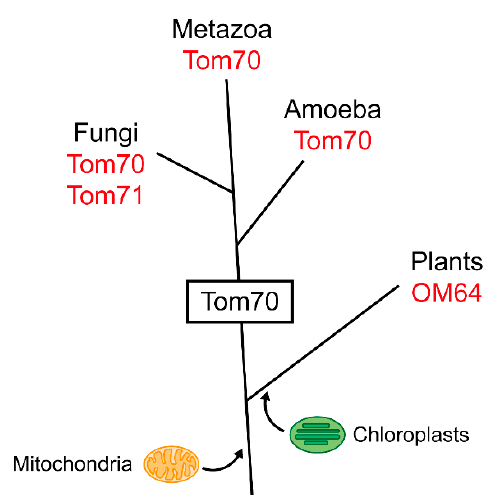
Figure 3. Tom70 and its functional analogs in different eukaryotic lineages. The mitochondrial outer membrane protein Tom70 is found in the eukaryotic kingdoms of metazoa, fungi and amoeba. Mitochondria of plants are lacking a Tom70, but they contain the outer membrane protein OM64, an unrelated TPR protein that serves similar functions.